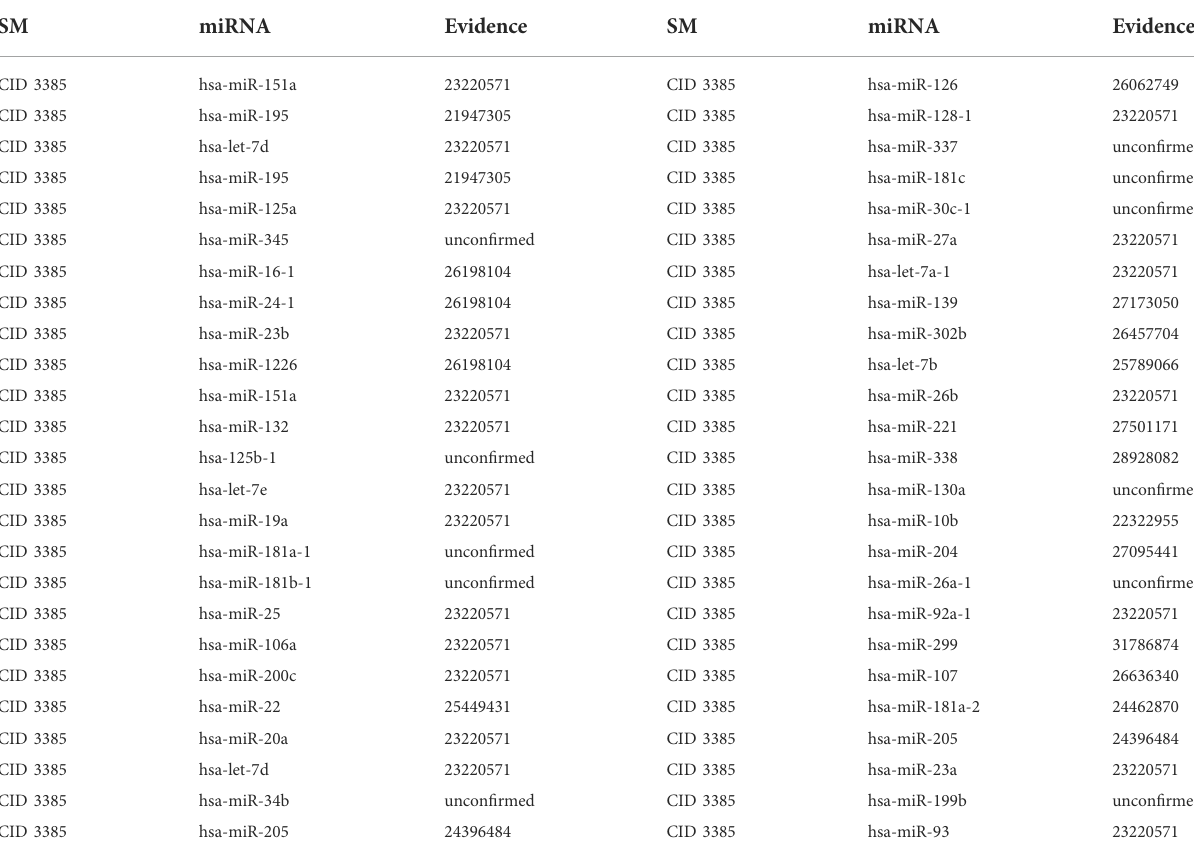
TABLE 3 Validation of the top 50 miRNAs associated with 5-Fu in the fi rst type of casestudies. The fi rst column records the top 1 – 25 relatedmiRNAs. The second column records the top 26 – 50 related miRNAs. SM